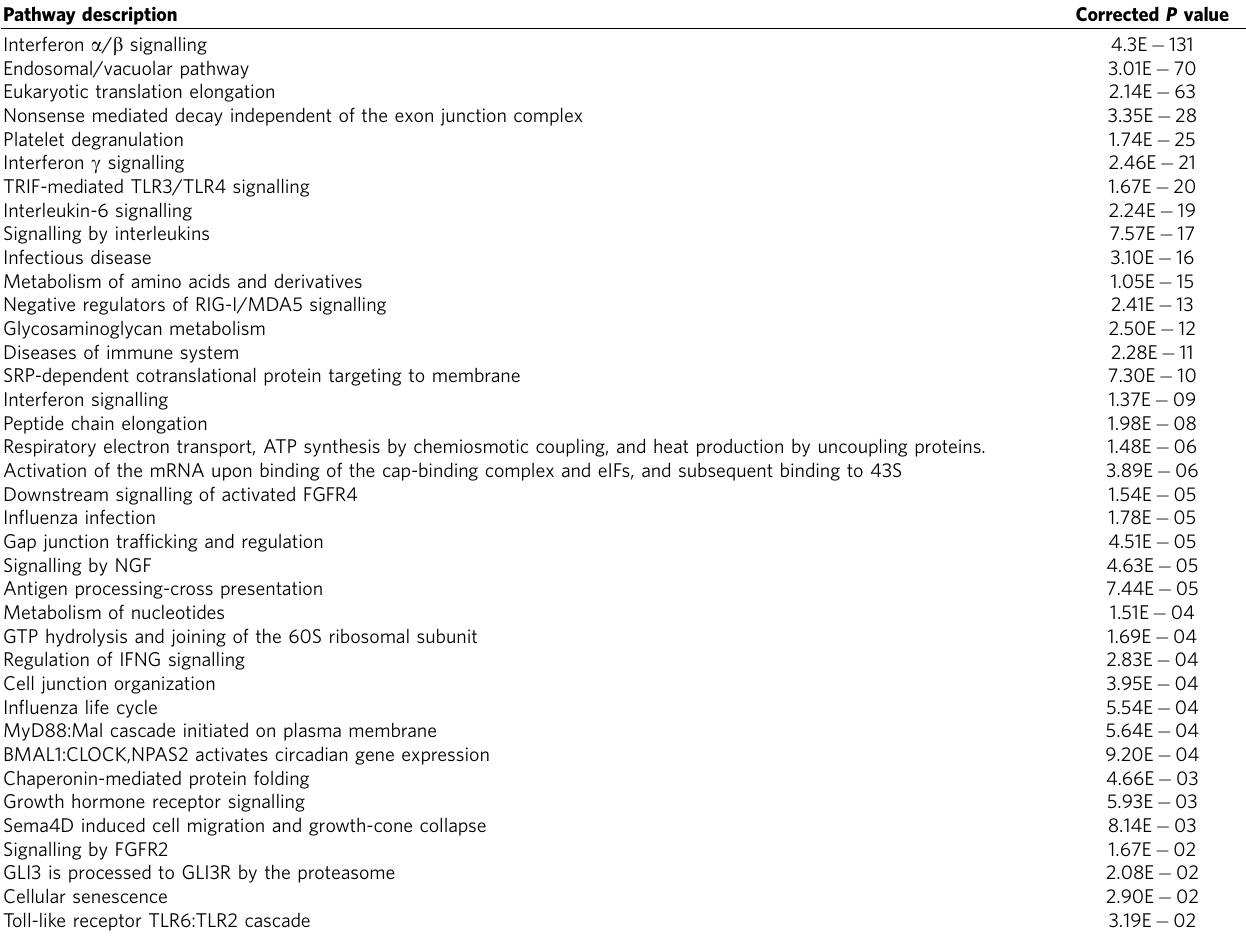
Table 1 | Selected pathways dysregulated upon chlamydial infection in iPSdMs and human blood monocyte-derived macrophages as shown by